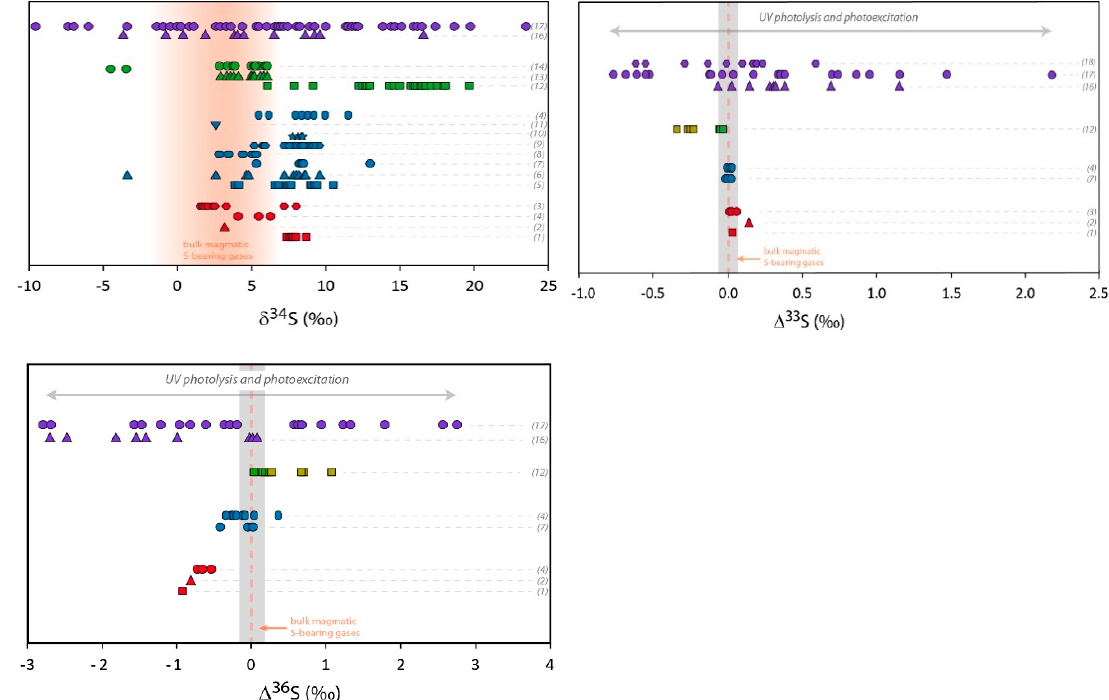
Figure 2. Multi O- and S-isotopic composition measured in volcanic sulfates. Red symbols represent primary sulfate samples collected at volcanic vents (aerosols or sulfate extracted from ashes). Blue symbols are sulfate samples extracted from volcanic deposits from tropospheric eruptions gathered at distances up to 100 km from the vent. Green symbols represent volcanic sulfates collected in deposits of super-eruptions at distances between 500 km and 5000 km from the volcanic systems. Pale green symbols correspond to ∆ 33 S and ∆ 36 S recalculated from the values represented by the dark green symbols, assuming dilution by non-volcanic sulfates [33]. Purple symbols represent sulfate samples from Antarctica ice cores. Mass dependent (non-MIF) compositions are emphasized by grey areas (taking into account the analytical uncertainties in 2 σ ) and bulk magmatic S-bearing gases composition by orange areas or dotted lines (see the Section 3.1 isotopic composition of S-bearing gases for further discussion). The theoretical δ 18 O and ∆ 17 O composition of secondary sulfate generated in the atmosphere by different oxidation pathways are reported in grey areas. The different oxidation pathways via OH, H 2 O 2 , O 3 , and O 2 -TMI are detailed in the introduction of this paper and in Figure 1. The effect of UV photolysis and photoexcitation of SO 2 on the sulfate ∆ 33 S and ∆ 36 S are shown by grey arrows. References of the figure: sulfate aerosols (1): [31]; (2): [30]; (3): [25] and references therein; sulfate extracted from volcanic ash (4): [30]; (5): [20]; (6): [35]; (7): [75]; (8): [76]; (9): [32]; (10): [77]; (11): [34]; (12): [33]; (13): [35]; (14): Unpublished data; (15): [78]; (16): [79–81]; (17): [82]. For the (16) and